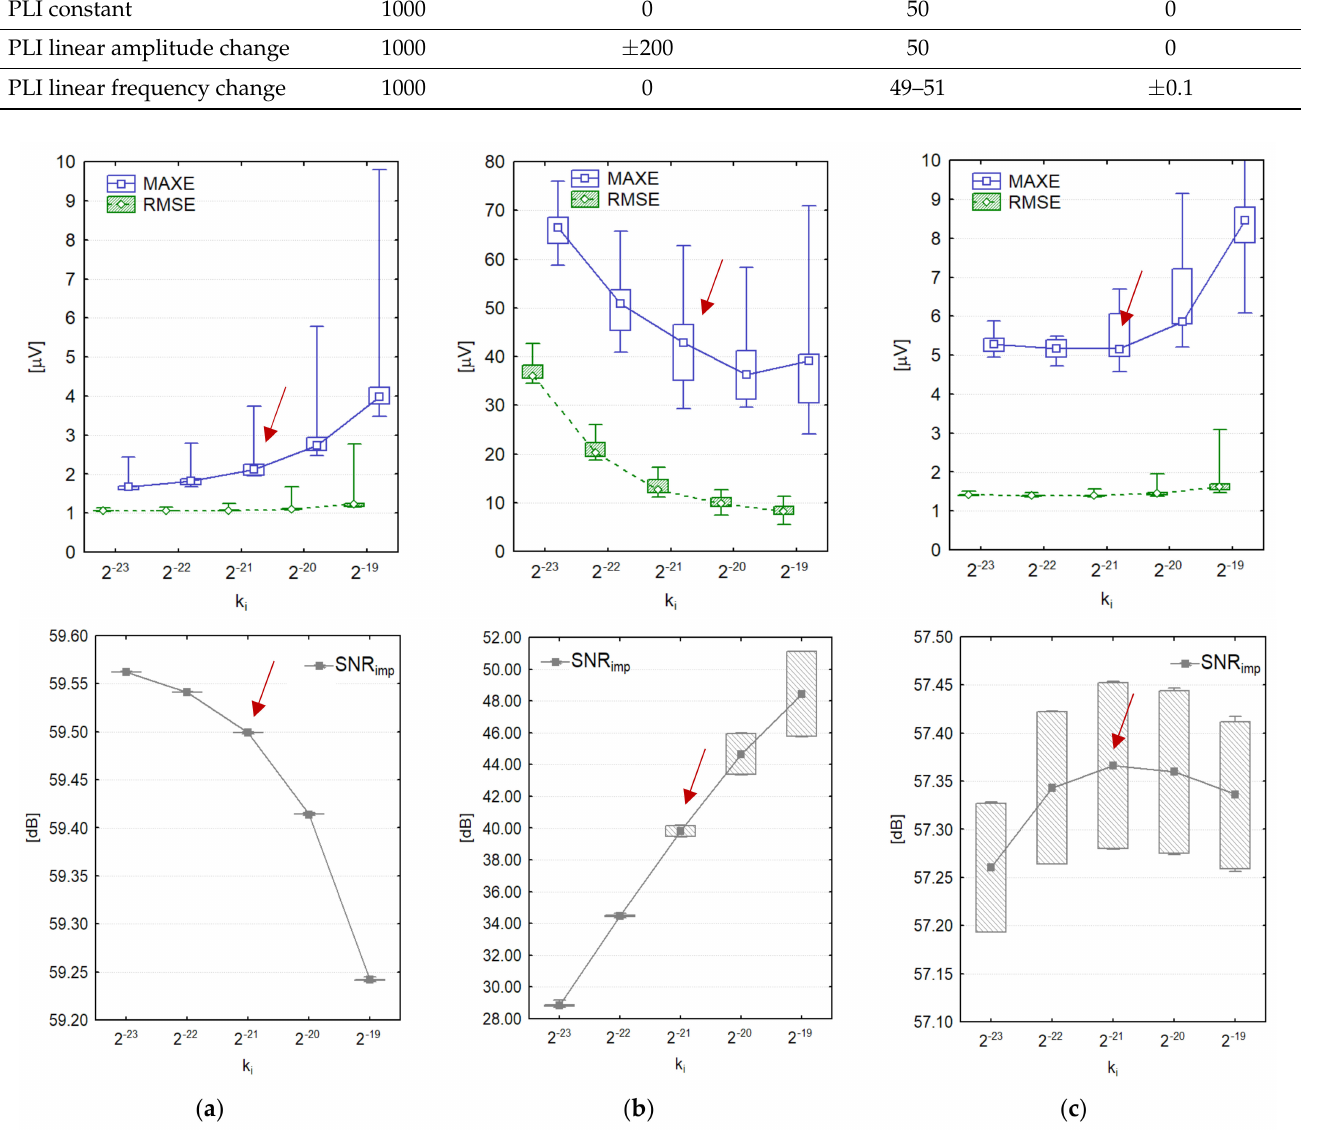
Figure 7. Optimization of the stability coefficient k i in the loop filter (Figure 6): Statistical distributions (median; box: 25–75%; whisker: min–max) of MAXE, RMSE, SNR imp computed for 10 s with the CTS-ECG CAL database with added PLI sinusoid according to the three settings in Table 1: ( a ) PLI constant, ( b ) PLI linear amplitude change, ( c ) PLI linear frequency change. The red arrows show the optimal choice of k i = 2 − 21 , seeking for output error minimization and SNR imp maximization as a conciliation between the three scenarios for variation in PLI